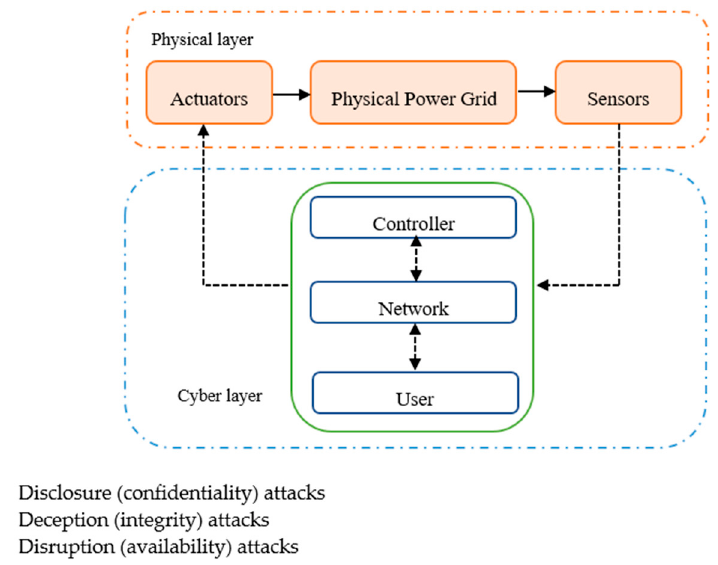
Figure 2. Three types of cyber-attacks.